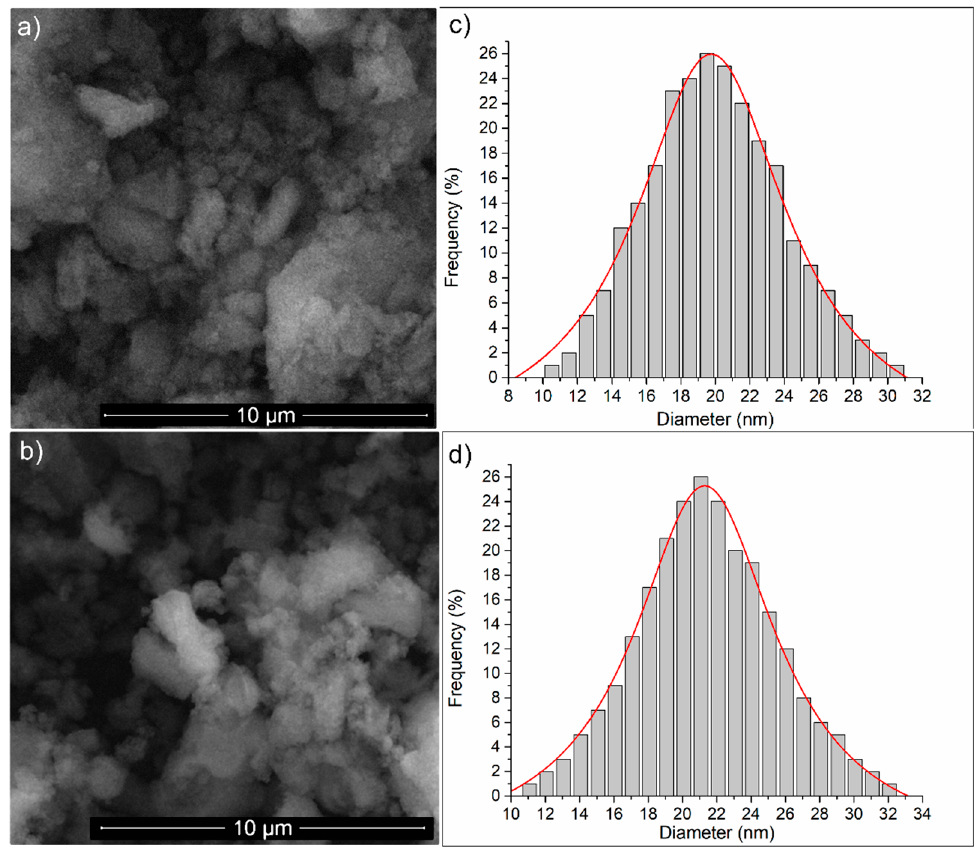
Figure 2. SEM images of ( a ) HAp and ( b ) HAp-P, and particle size distributions of ( c ) HAp and ( d ) HAp-P samples.